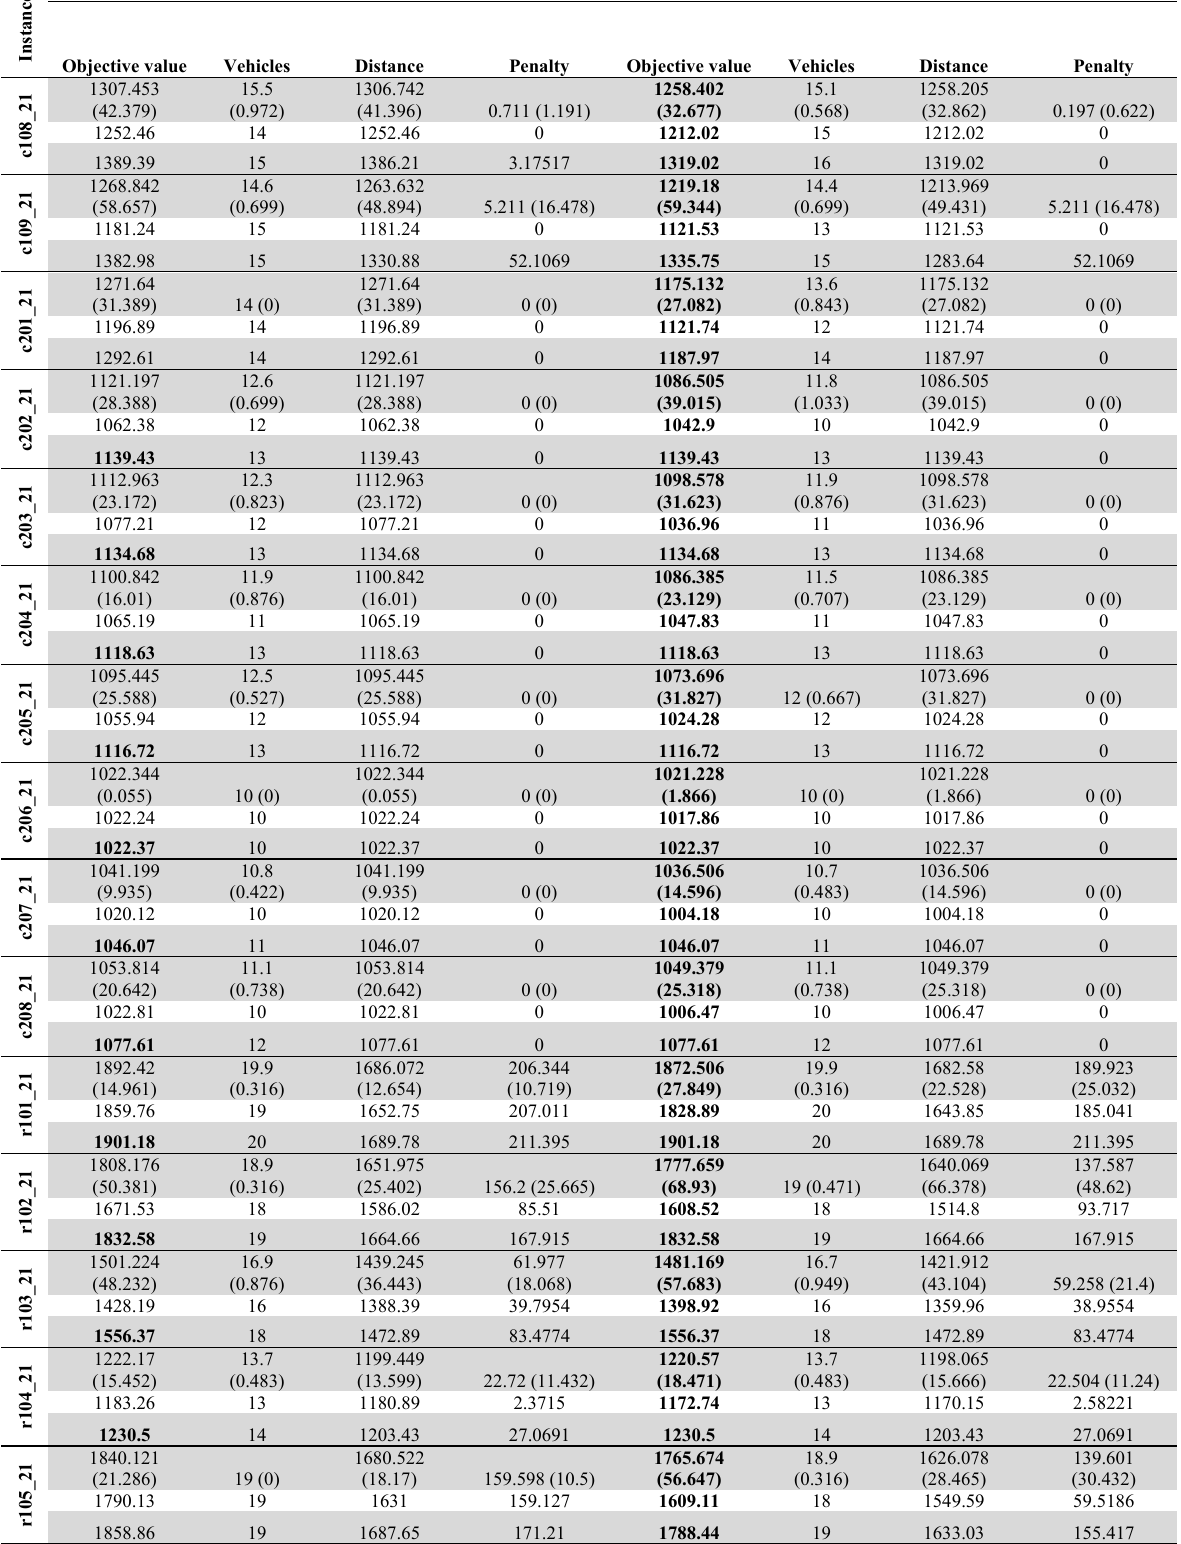
The obtained results for larger-sized instances